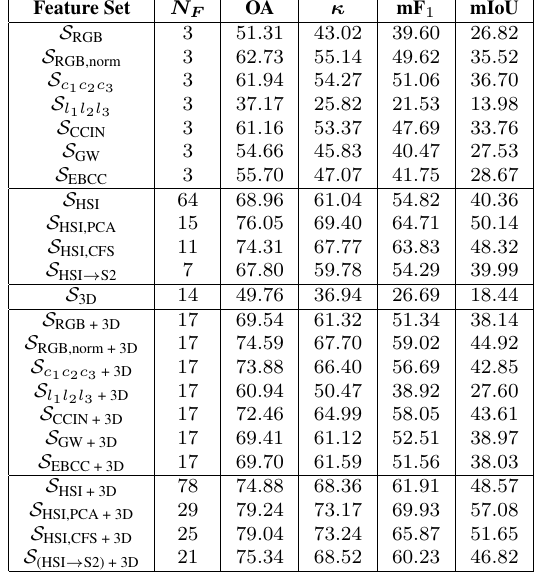
Table 1. Number N F of involved features and achieved classification results (OA, κ , mF 1 and mIoU in %) when using different feature sets as the basis for